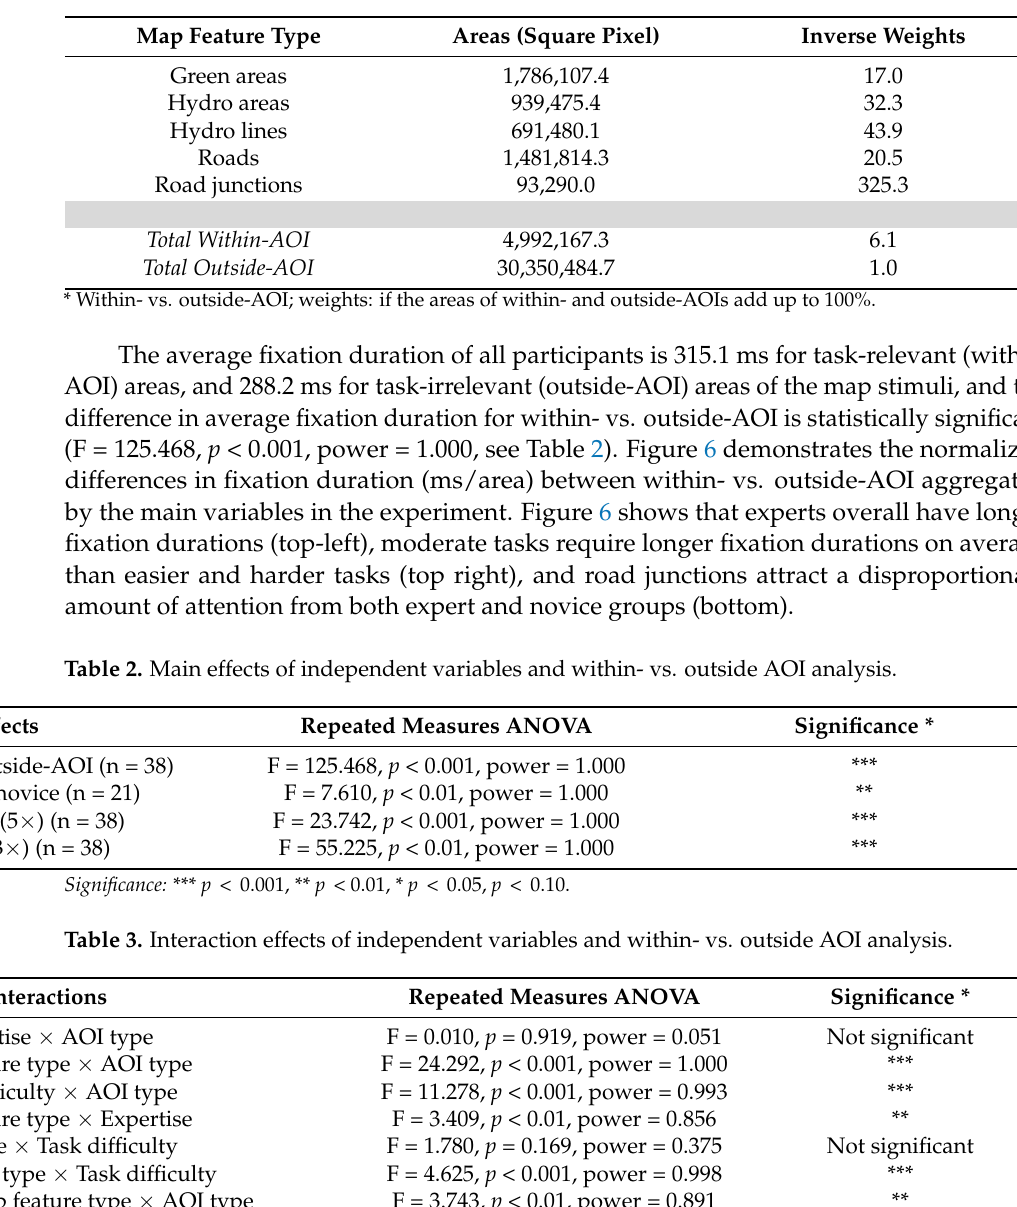
Table 1. Factors for normalizing the fixation durations by area (AOI size).